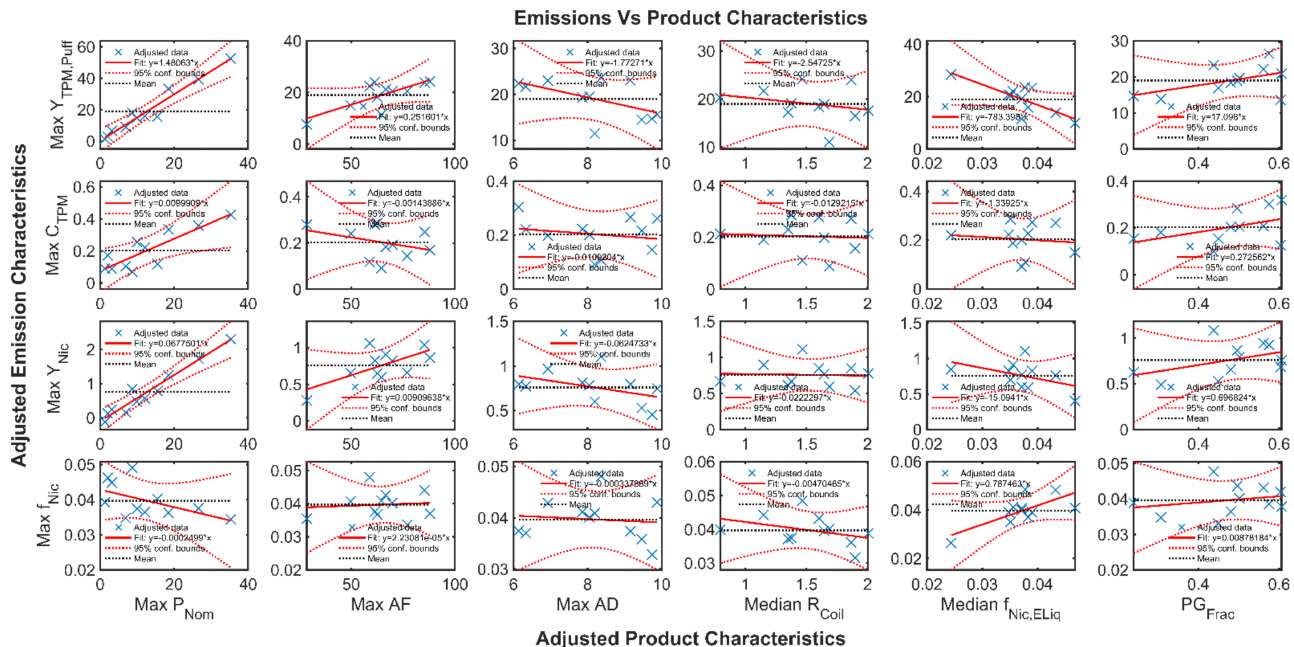
Figure 10. Added variable assessment of each adjusted emission characteristic (Max ˆ Y TPM , Max ˆ f ˆ C ˆ Y ) as a function of each adjusted product characteristic (Max P TPM , Max Nic , and Max Nic MaxAF, MaxAD, R Coil , f Nic , f PG ) while holding other product characteristics constant. Thirteen pod- and pen-style ENDS devices are represented in the data